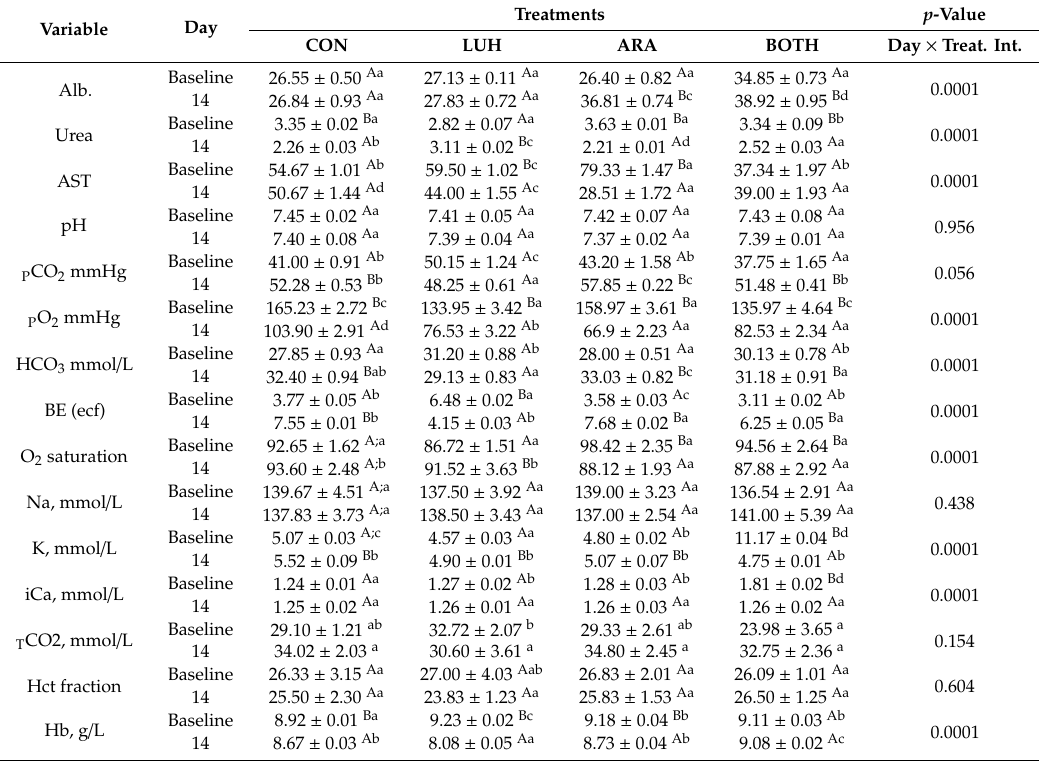
Table 4. Blood parameters of calves fed with milk replacer only (CON) or supplemented with LUHS245 strain (LUH) or arabinogalactan (ARA) alone and together